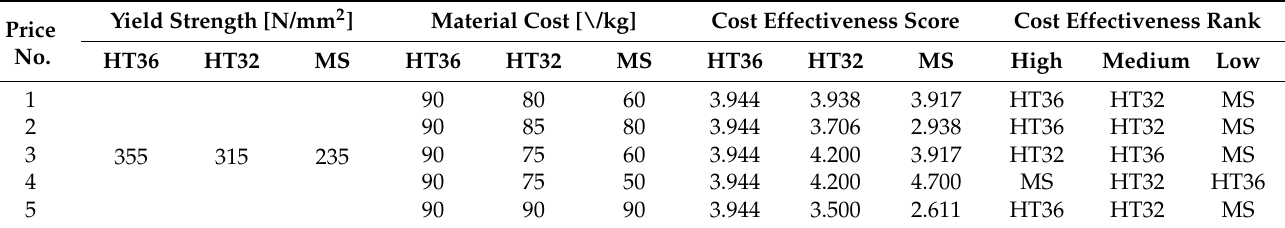
Table 2. Material price variation.